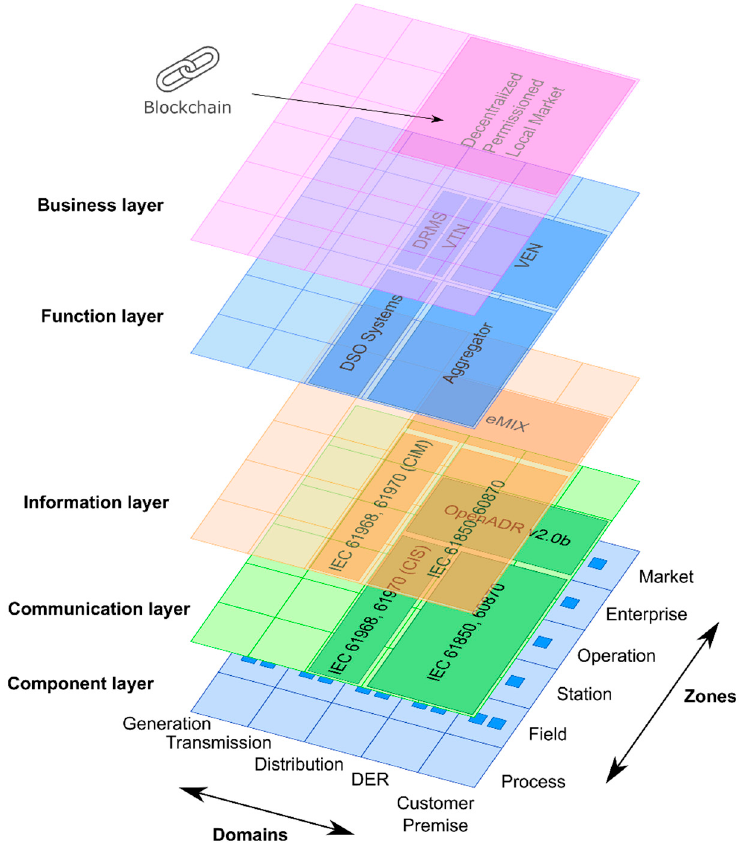
Figure 6. Architecture according to Smart Grid Architecture Model (SGAM).